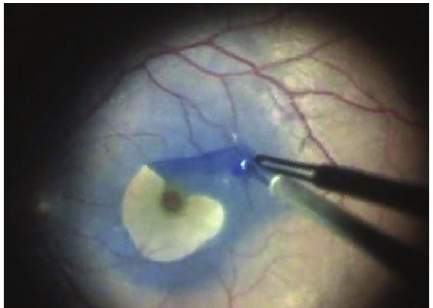
Figure 1: ILM peeling after staining with brilliant blue dye